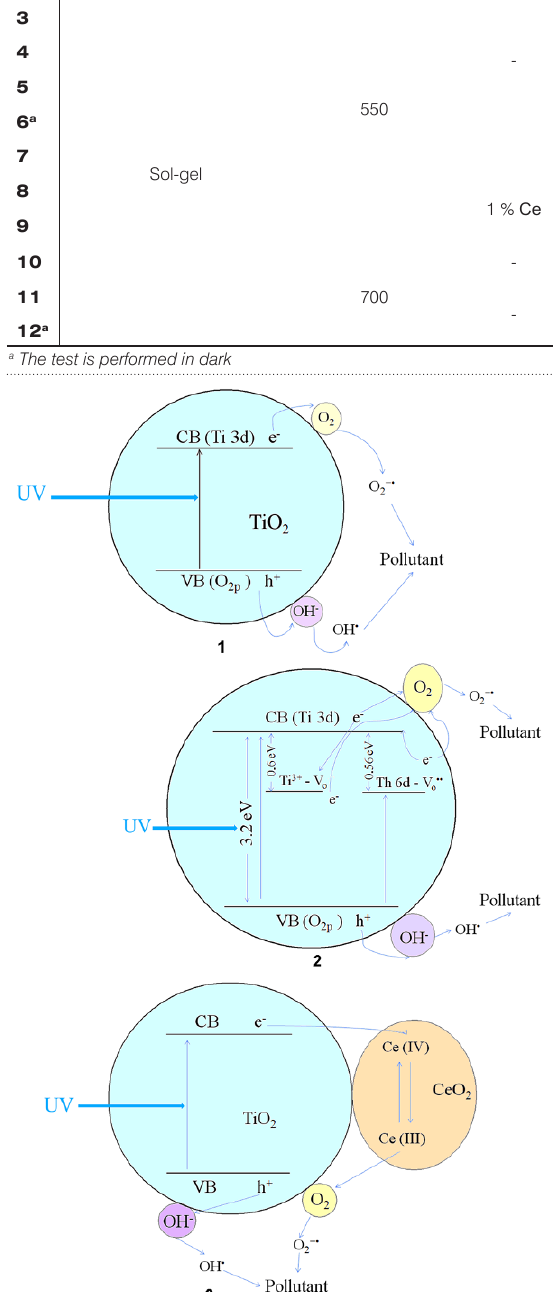
Figure 3. Schematic description of photocatalytic processes with the participation of pure (1) and Th- (2) or Ce- (3) doped